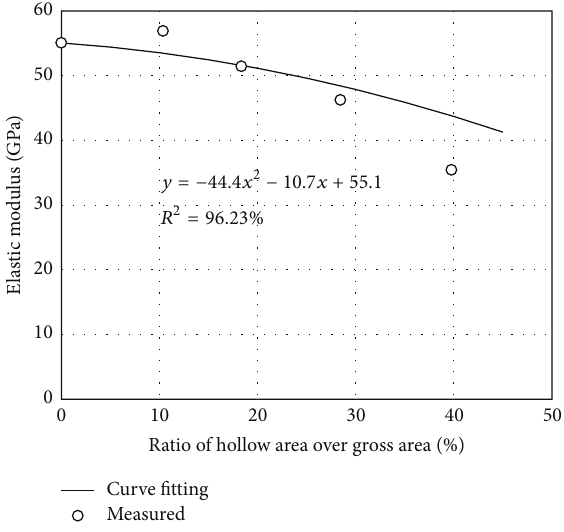
Figure 11: Elastic modulus for hollow section